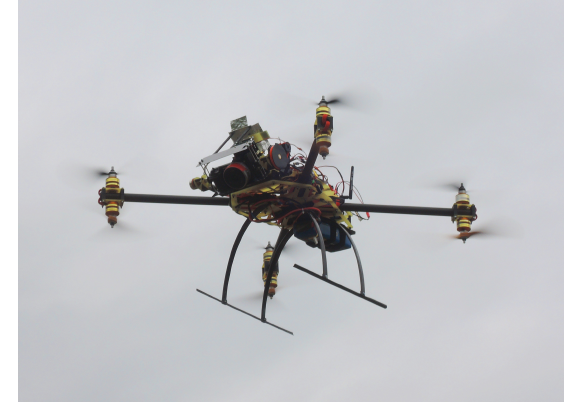
Figure 1: Octocopter with the